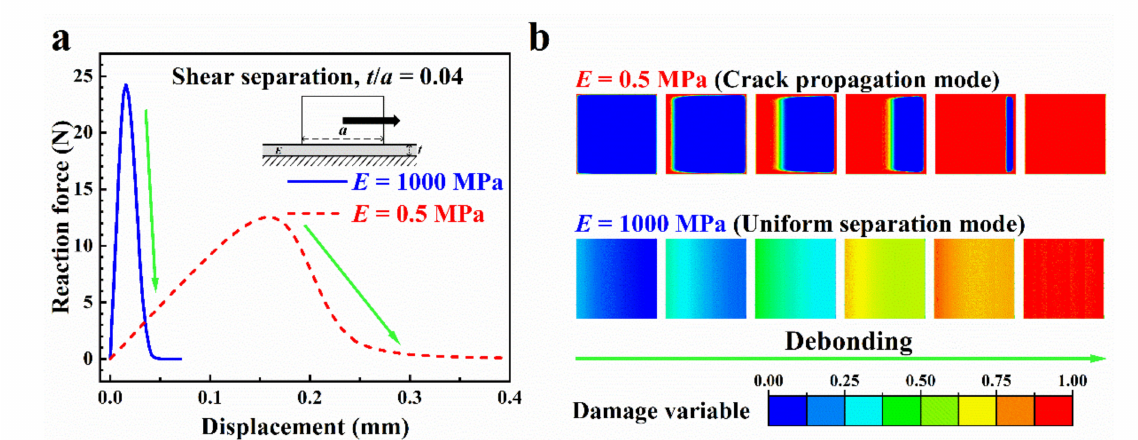
Figure 9. ( a ) Force–displacement curves and ( b ) changes of interface damage variable during detachment for shear separation, for E = 0.5 and 1000 MPa ( t / a = 0.04).